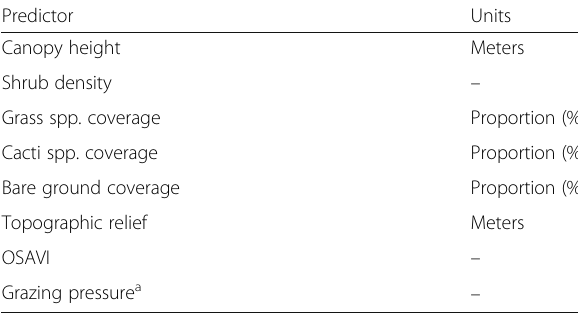
Table 1 Summary of predictor layers included in